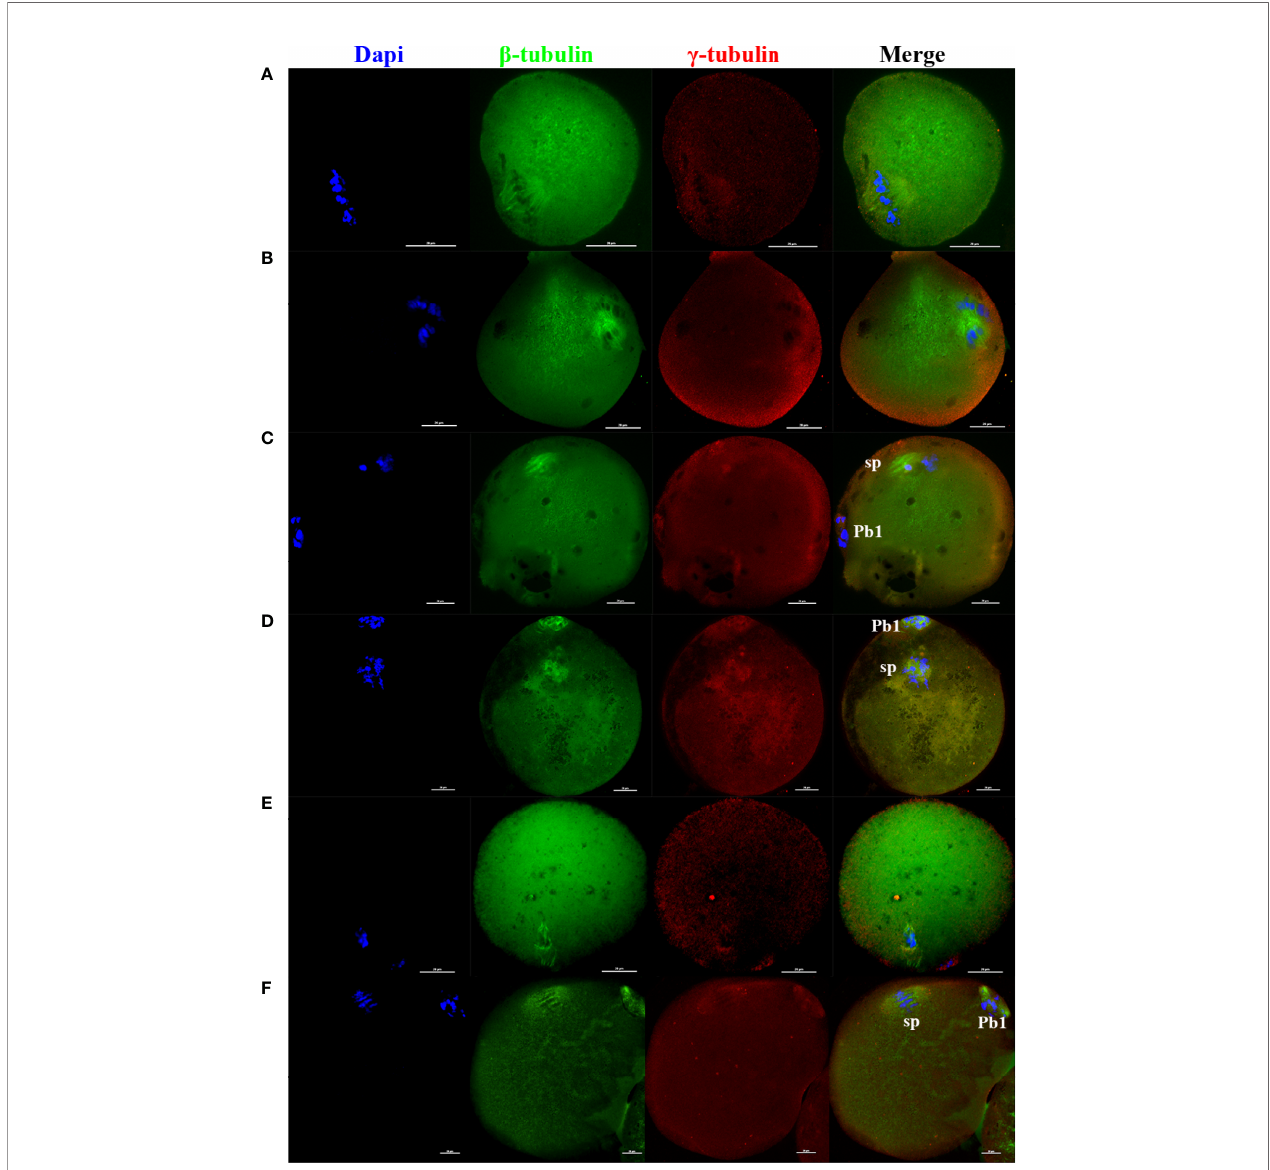
FIGURE 3 | As the electrofusion stimulation number increased, several typical abnormalities in the chromosome arrangement and spindle assembly were generated, especially in TEF. Representative images from the immuno fl uorescence staining are shown. (A) The spindle was signi fi cantly wider, while the chromosomes and g -tubulin localization were normal. (B) Chromosomes were multilaterally arranged outside the spindle, and microtubules were disordered, with disordered g -tubulin localization, forming a multipolar spindle. (C) Chromosome distribution was disordered, some in the center of the spindle, others at one pole of the spindle, microtubules at one pole of the spindle were fractured, with the g -tubulin dissociated from the poles of the spindle, irregularly scattered in the spindle microtubules or in the cytoplasm, forming a unipolar spindle; (D) Chromosomes had a disorderly arrangement throughout the whole spindle region. The spindle microtubules were fractured and disordered, with g -tubulin dissociated from the poles of the spindle and dispersed irregularly on the microtubules, forming a poleless spindle. (E) The arrangement of the microtubules was disrupted, with the chromosomes having a disorderly arrangement in the center of the spindle. (F) The spindle was over- elongated. Scale bar, 20 m